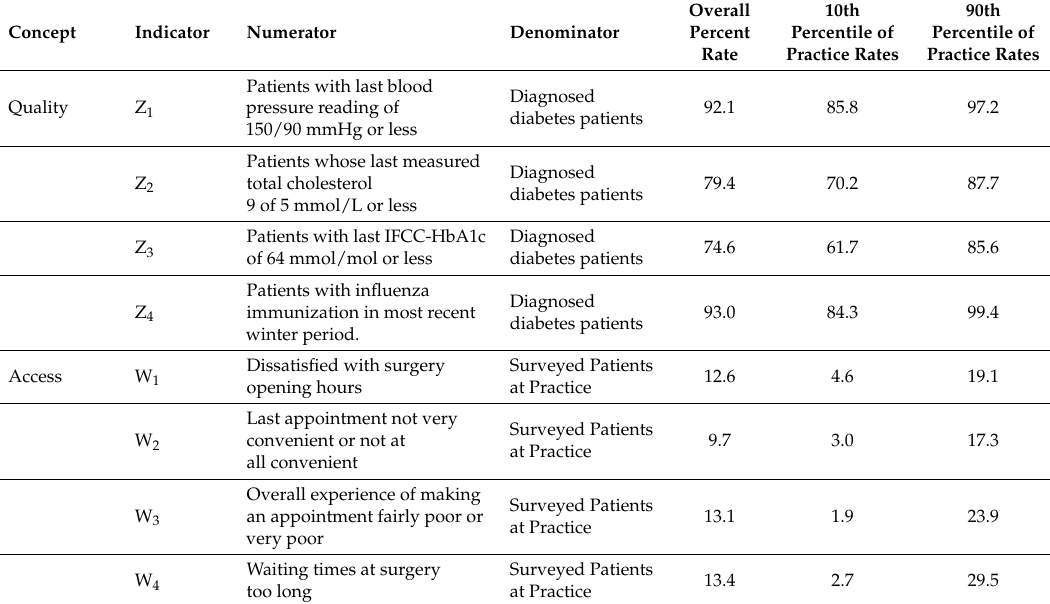
Table 1. Indicators for quality of care and